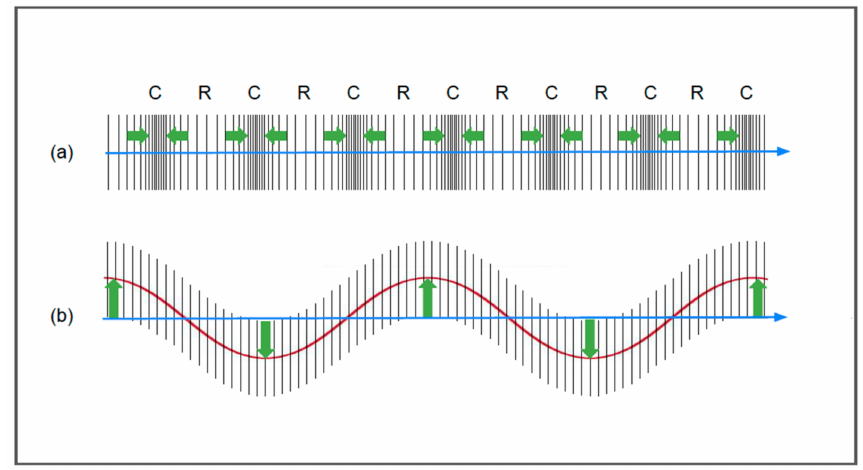
Figure 3. Longitudinal waves ( a ) and shear waves ( b ). The green arrows and the red line in figure (b) show the movement of the molecules with respect to the axis of propagation.